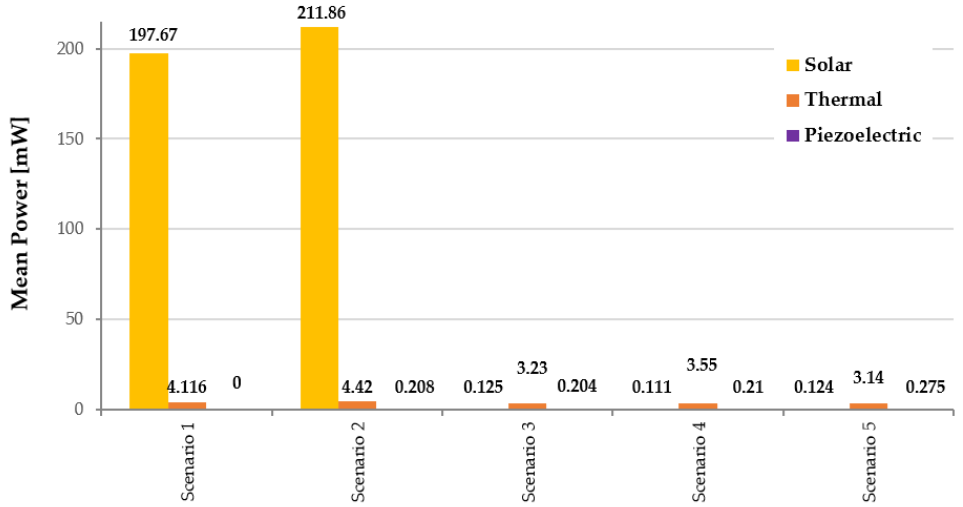
Figure 18. Histogram showing the energy distributions for the three different harvesting subsystems in the five considered scenarios.